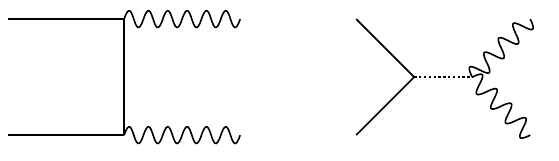
Figure 8 . Feynman diagrams contributing to t ¯ t → W +